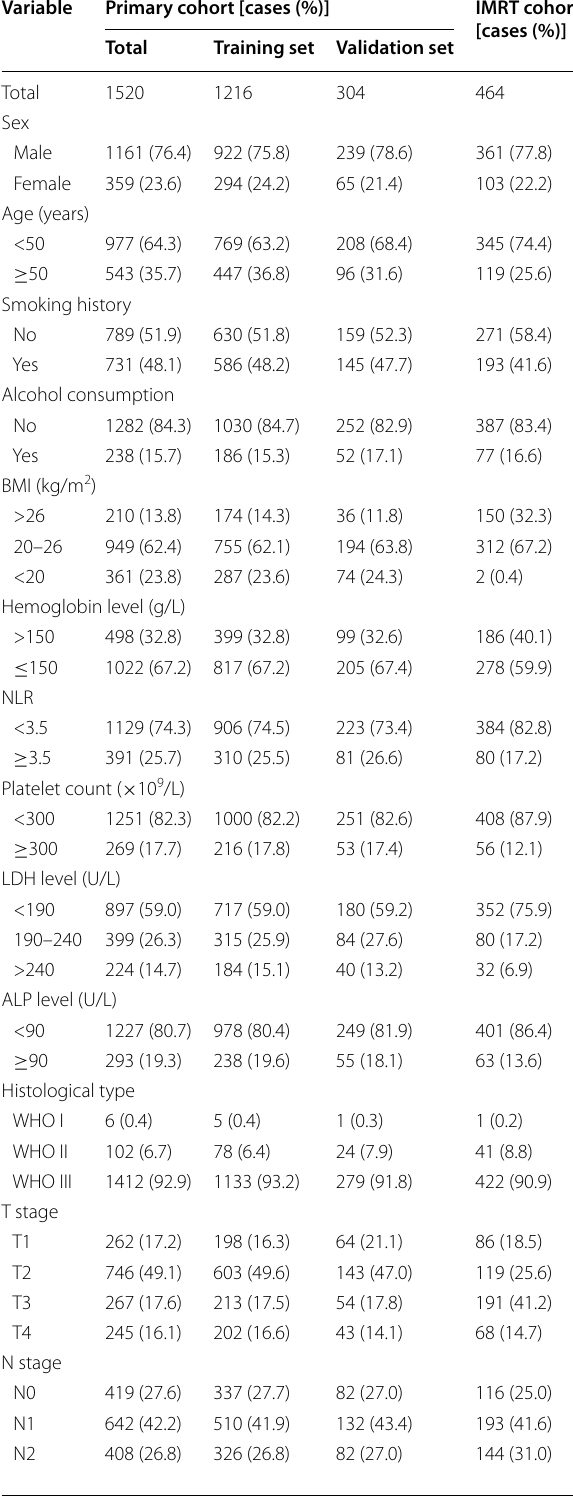
Table 1 Demographic and clinicopathologic characteris- tics of non-metastatic nasopharyngeal carcinoma patients in the training set, internal validation set, and IMRT